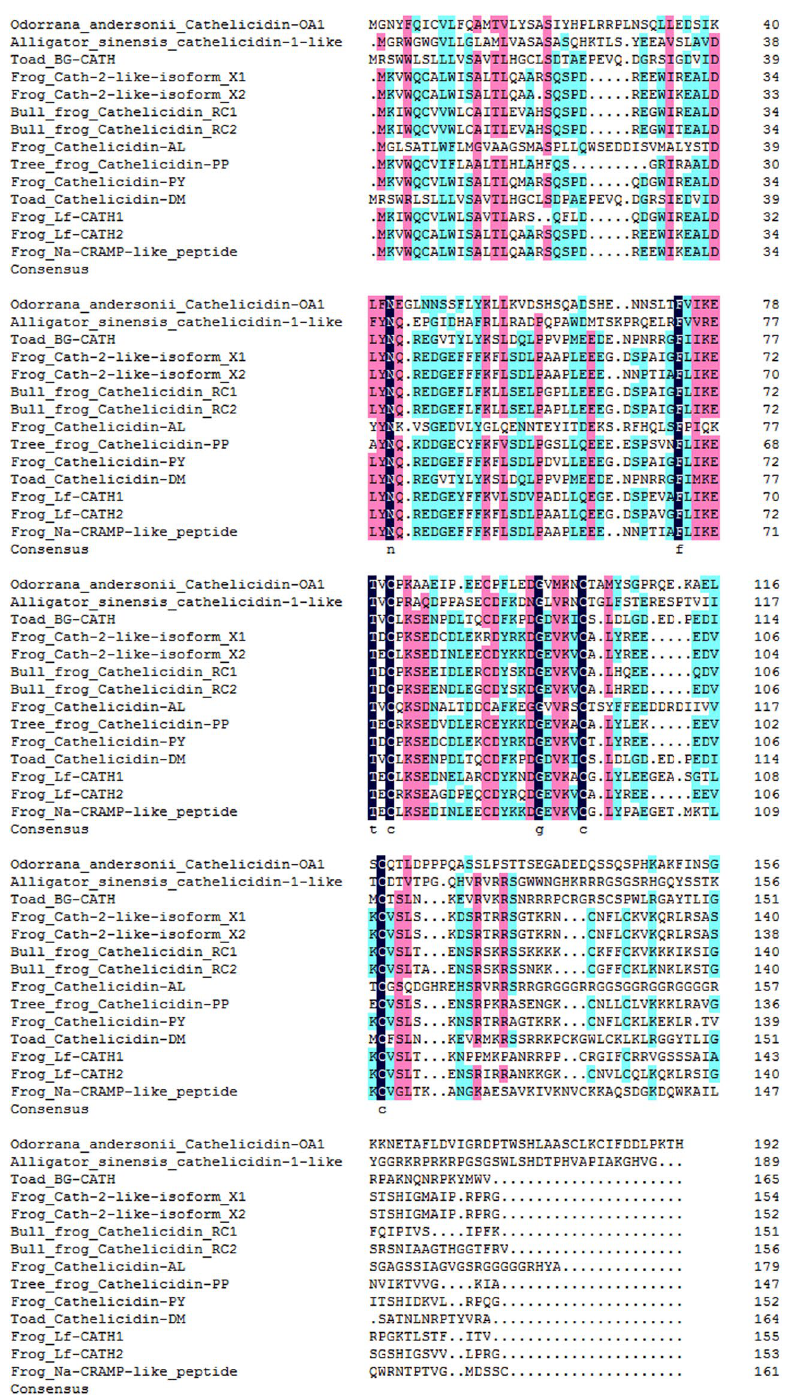
Figure 3. Multiple sequence alignments of cathelicidin-OA1 with several known cathelicidins. Dashes were inserted to optimize